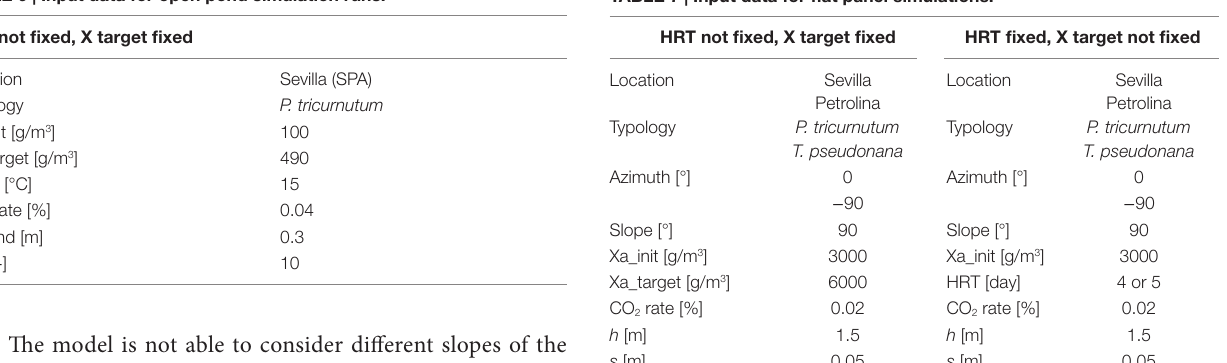
TaBle 6 | input data for open pond simulation runs. TaBle 7 | input data for flat panel simulations.